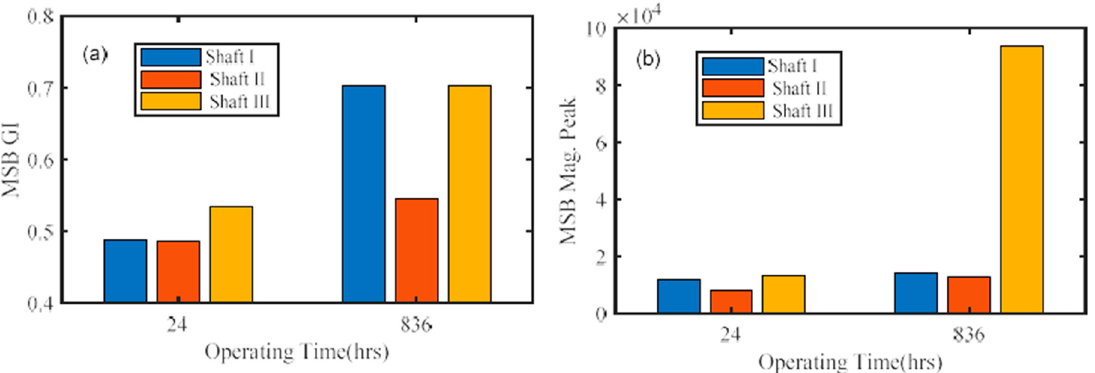
Figure 16. MSB-Gini Index and peak values of bearings in gearbox versus operating time, ( a ) MSB- Index and ( b ) MSB magnitude peak under di ff erent operating Gini Index and ( b ) MSB magnitude peak under different operating time.